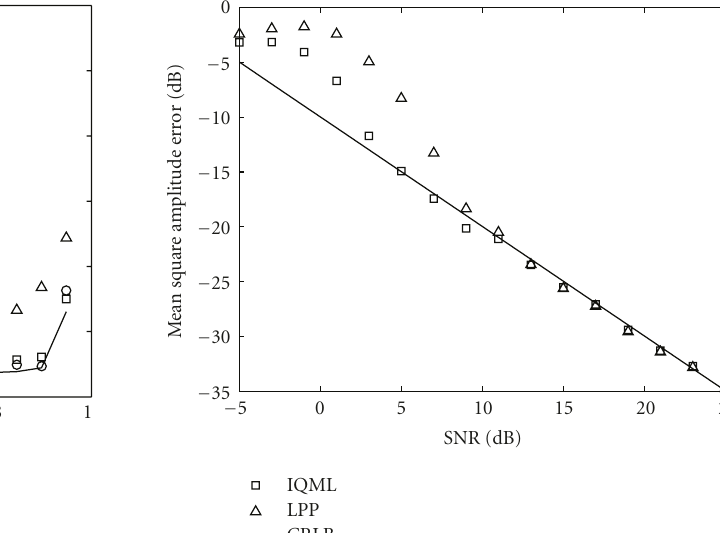
Figure 16: MSE for A 1 of multiple complex sinusoids.